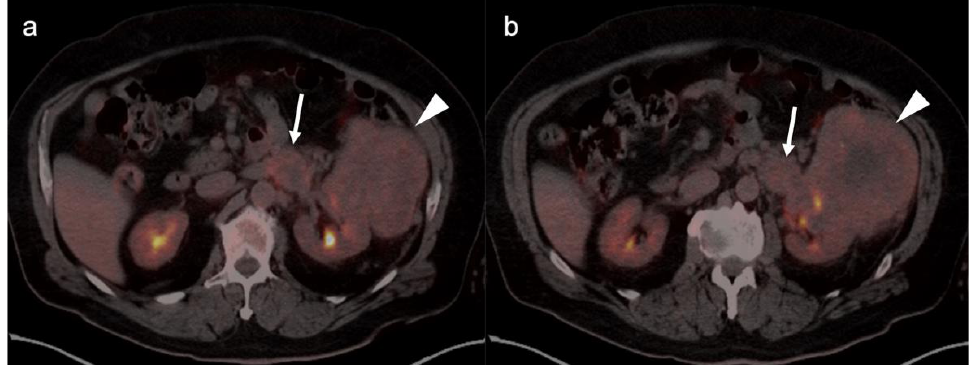
Figure 51. Large renal cell carcinoma with renal vein invasion. FDG PET-CT ( a , b ) shows a large left renal mass extending into the pararenal space (white arrowhead) and invading the left renal vein (white arrow).